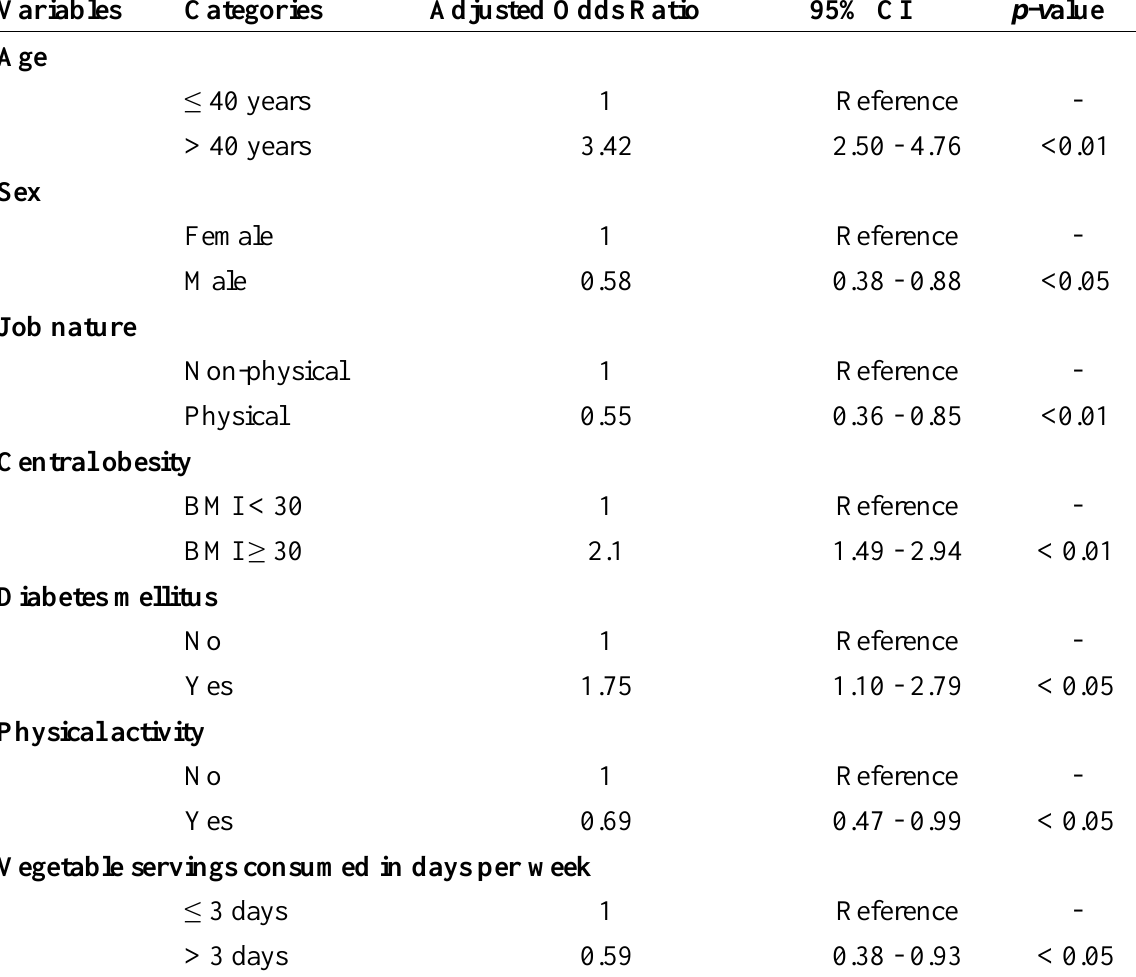
Table 5: Multivariable analysis of risk factors and hypertension among those surveyed using the WHO STEPS in Jalalabad, Nangarhar,